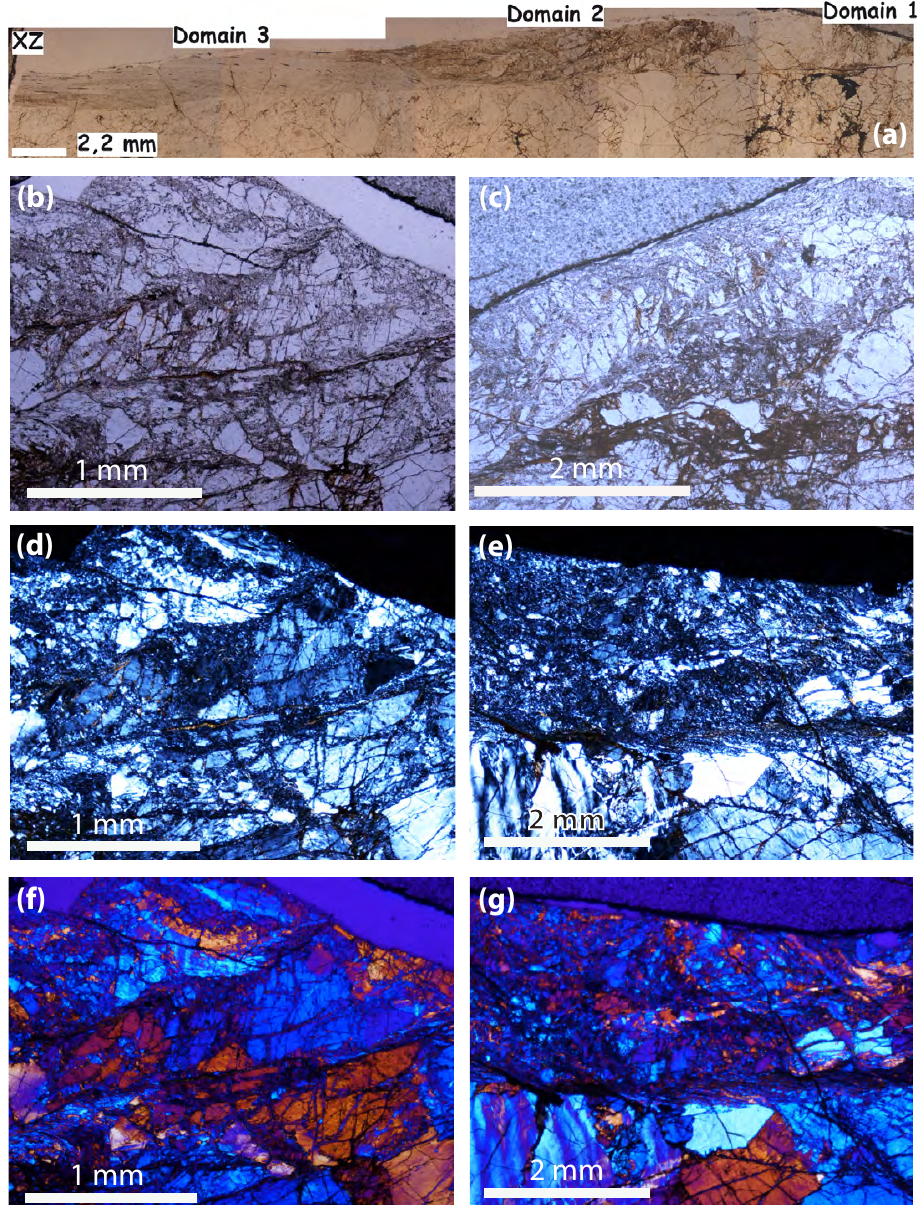
Figure 5. (a) Microscopic view of millimetre-scale shear zone nucleated after brittle precursor, with indication of the structural– compositional domains within the shear zone. Domain 1: relict domain of cataclasite; Domain 2: foliated-cataclasite/phyllonite; Domain 3: ultramylonite. (b–g) Micrographs showing details of cataclastic relicts in Domain 1; (b, c, d) crush microbreccia showing angular to subangu- lar quartz and feldspars clasts with intergranular and intragranular microfractures. Stilpnomelane is observable in (c) as filling microfractures. In (d) clasts of quartz and feldspars show relict internal deformations similar to those of the host protomylonite. (e) Protocataclasite with submillimetre-sized quartz and feldspar clasts within a fine-grained matrix. (f, g) Cataclasite with quartz and feldspar clasts in fine-grained matrix. The angular fragments and their grain size distribution are indicative of brittle comminution. (a, b, e) Images with plane-polarized light, (d, f) cross-polarized light, and (d, g) cross-polarized with a lambda plate.